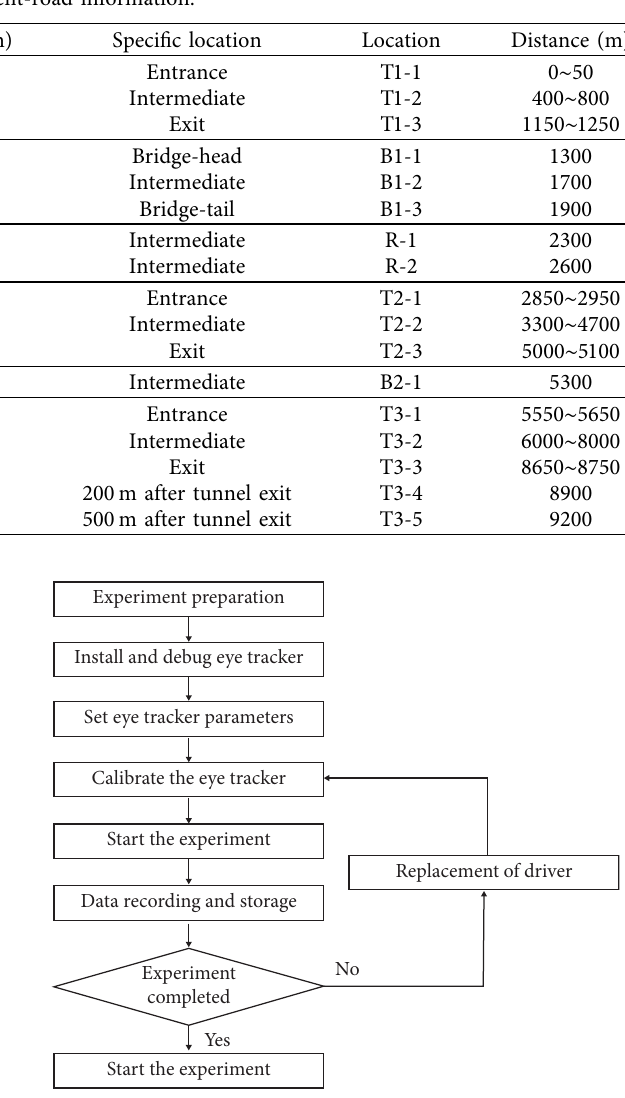
Figure 3: Te experimental fowchart.